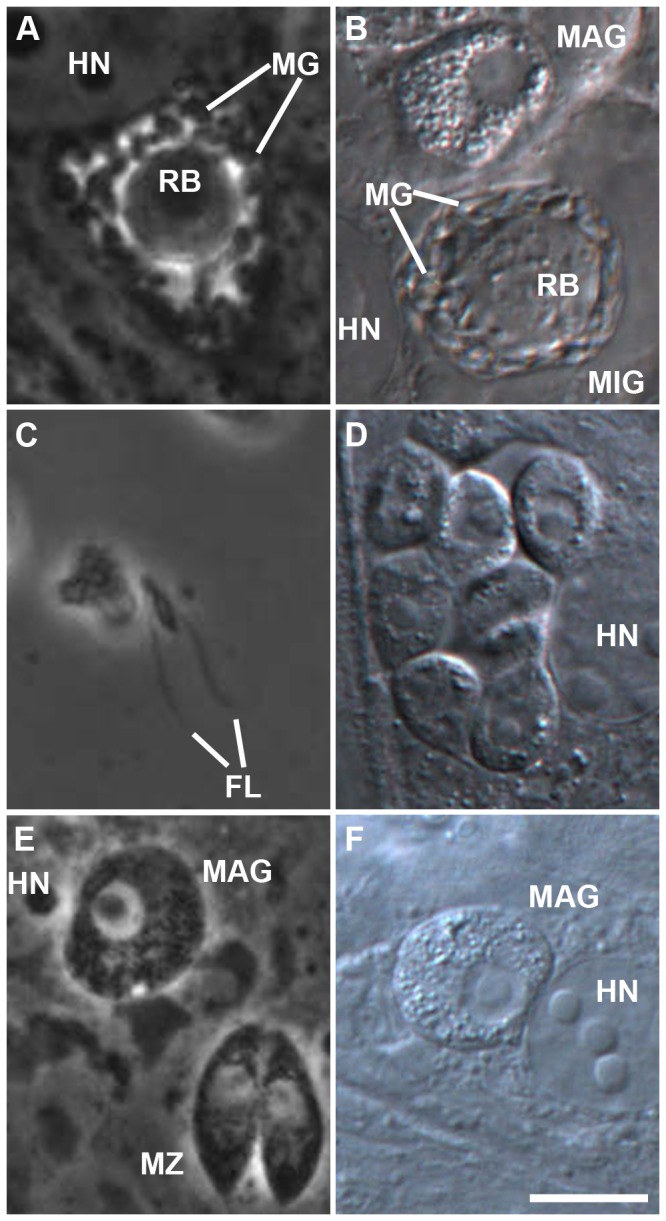
Sexual stages of

I

. suis
 in intestinal porcine epithelial cells (IPEC-J2).(A) PC image of a mature microgamont with intracellular microgametes (MG) surrounding the residual body (RB) on dpi 14; (B) DIC image of a mature microgamont (MIG) and a macrogamete (MAG) in the neighbouring host cell on dpi 13, notice the pronounced granular structure of the MAG; (C) PC image of a free microgamete in motion showing the typical two flagella (FL) on dpi 8; (D) presumptive young macrogamonts within one parasitophorous vacuole, notice the distinct nucleoli and the granular structure of the cytoplasm typical for macrogamonts; (E) PC image of a mature macrogamete and a pair of type I merozoites (MZ) on dpi 7; (F) DIC image of a mature macrogamete on dpi 19. DIC, differential interference contrast; dpi, days post infection; HN, host cell nucleus; PC, phase contrast; bar = 10 µm.